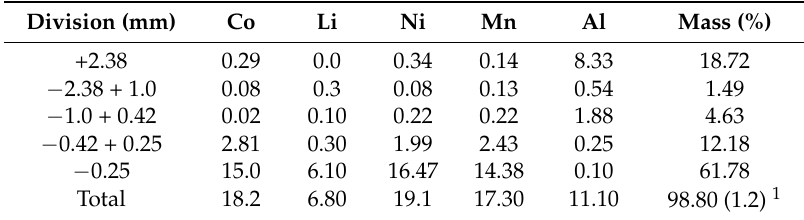
Table 2. Metal composition of different